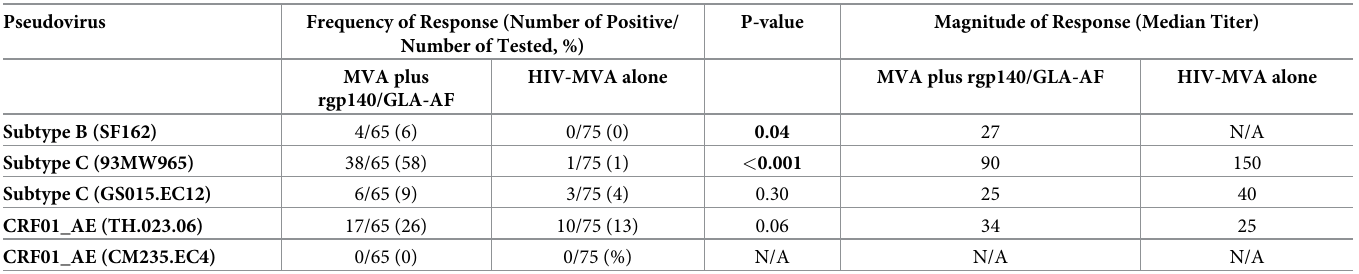
Table 4. Neutralizing Antibodies (NAb) determined four weeks after the final vaccination using the TZM-bl cell platform by second randomization. Pseudovirus Frequency of Response (Number of Positive/ Number of Tested,